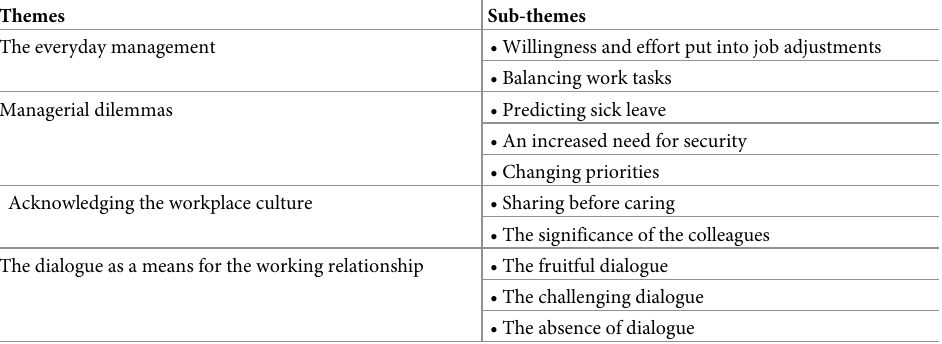
Table 2. Themes and sub-themes identified in the